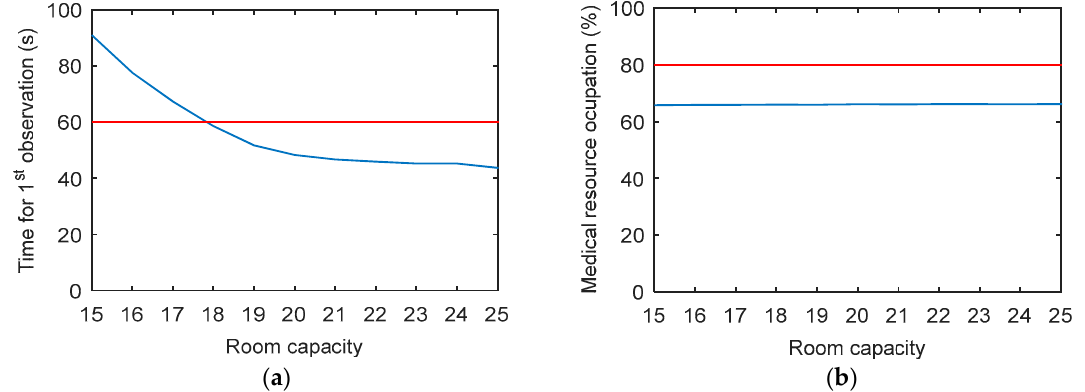
Figure 15. Obtained values for different capacity scenario: ( a ) waiting time for first medical intervention (blue line—simulation model, red line—Manchester time); ( b ) medical resource occupation (blue line—simulation model, red line— occupation rate limit).